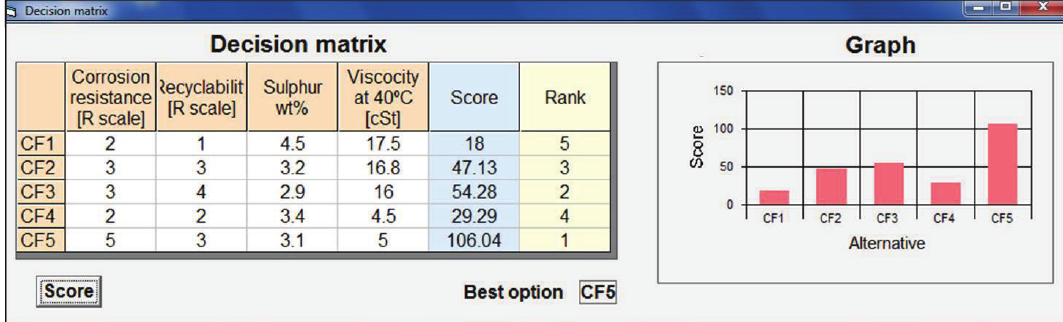
Figure 8: Decision matrix for Example